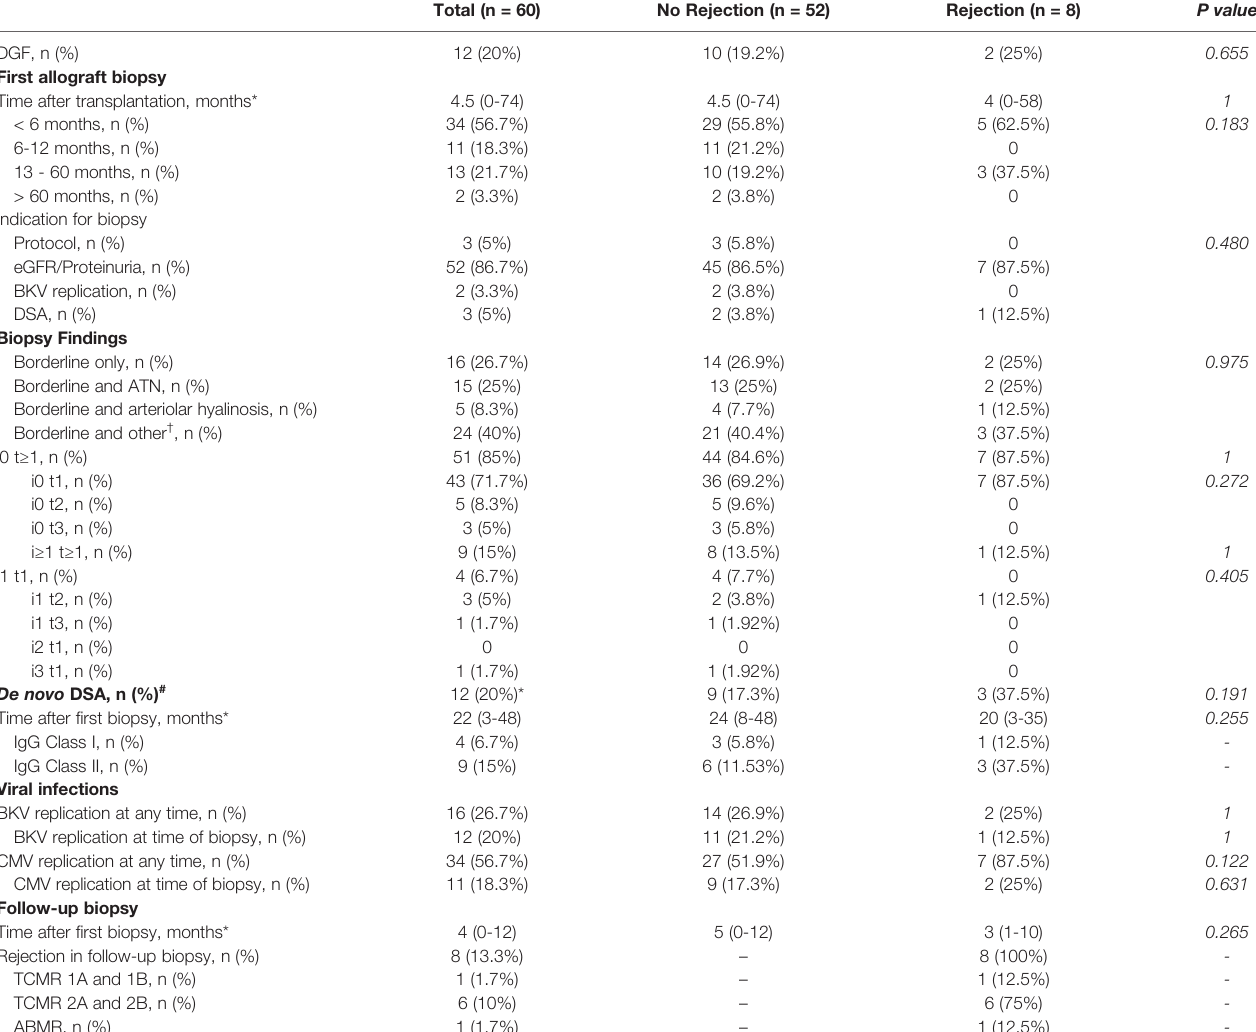
TABLE 1B | Outcomes of KTRs of KTRs with/without acute rejection in follow-up